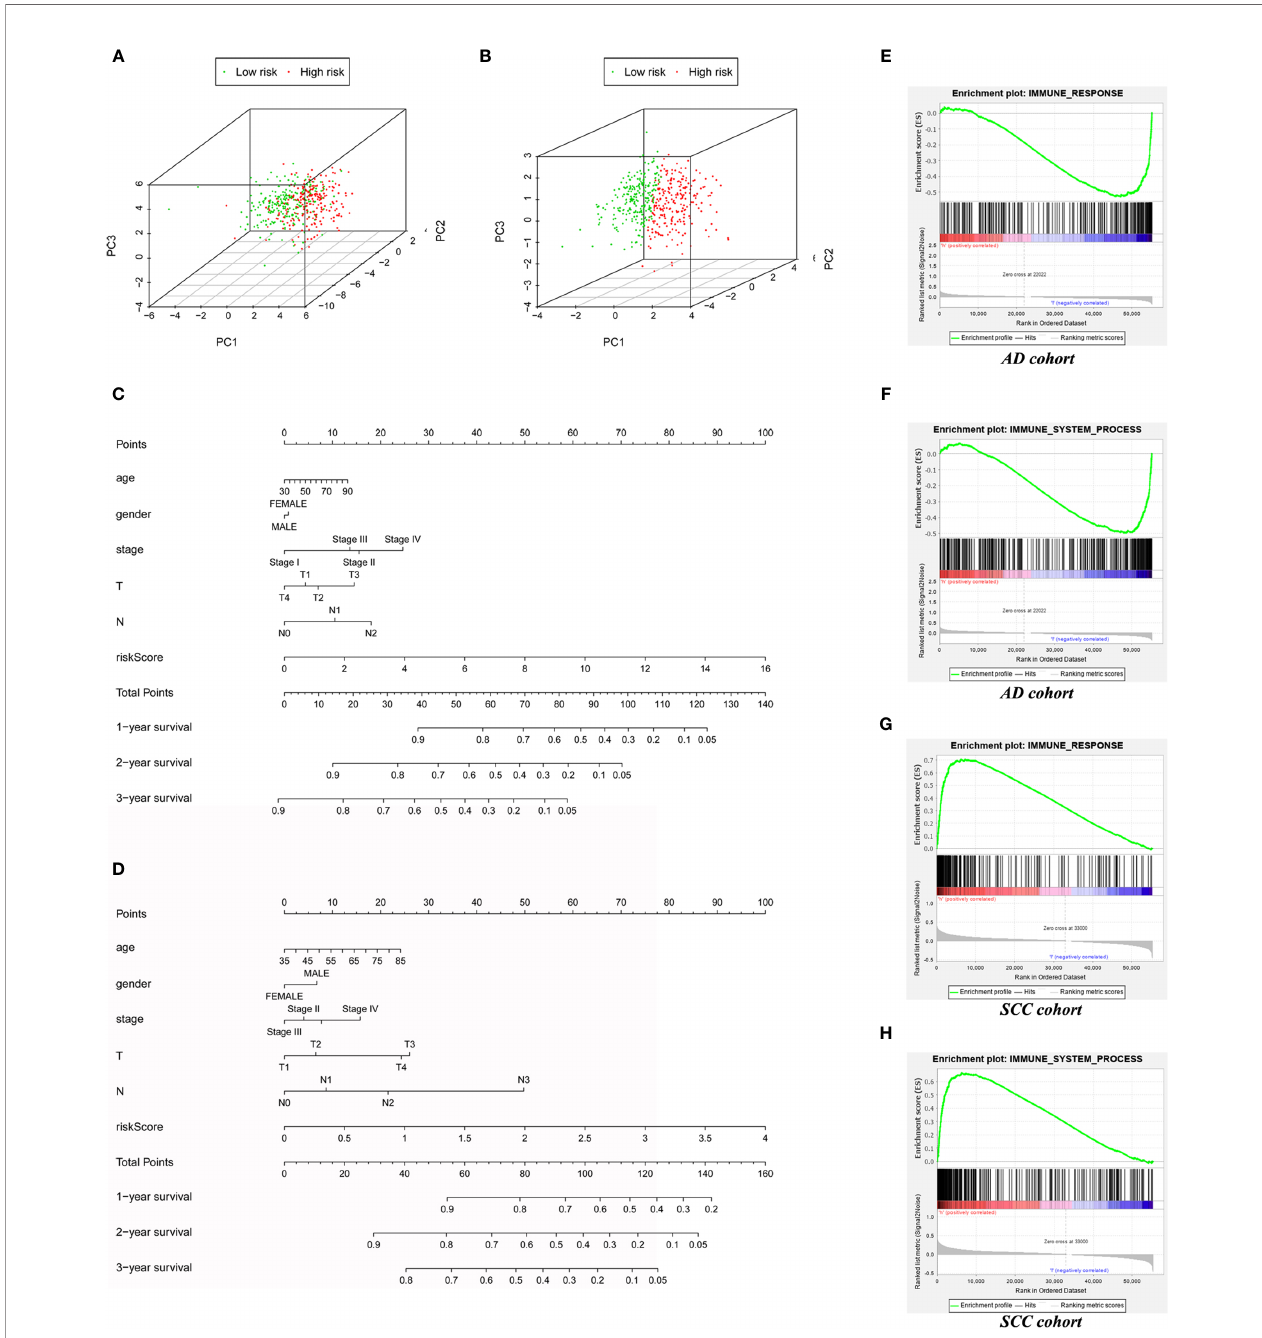
FIGURE 4 | The expand application of risk score in prognostic prediction and immune status assessment. The PCA based on AD immune-related LncRNAs model (A) and SCC ’ s (B) to test the discrimination between low-risk and high-risk patients. (C) The Nomogram for AD cohort (C) and SCC cohort (D) to predict 1-year, 2- year and 3-year prognosis. (E) The GSEA based on “ immune response ” gene set for AD patients. (F) The GSEA based on “ immune system process ” gene set for AD patients. (G) The GSEA based on “ immune response ” gene set for SCC patients. (H) The GSEA based on “ immune system process ” gene set for SCC